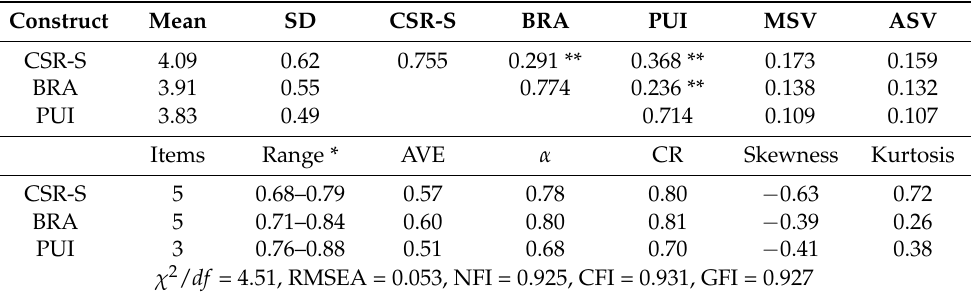
Table 2. The results of correlation, validity, and reliability analyses.